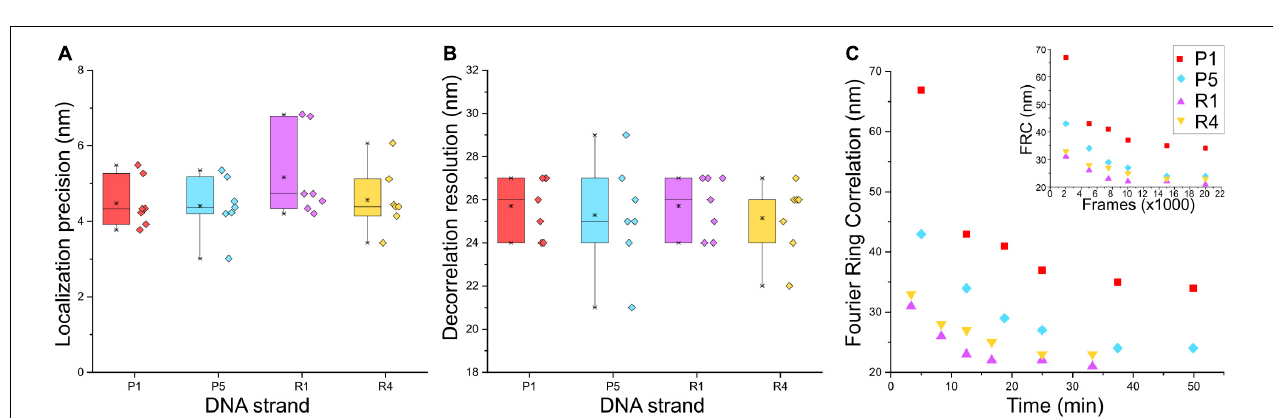
FIGURE 2 | (a) A four-target overlay DNA-PAINT image of MNTB tissue with two calyx synapses and corresponding postsynaptic principal cell (stippled lines), capillaries (dotted lines), and a graphical representation of the calyx of Held (inset). (i–vii) Magnification of regions within the primary image (a) showing different protein morphologies and organization of tubulin, mitochondria, MAP2, and VGLUT1 within the MNTB. Scale bar 5 µ m (a) and 0.5 µ m (i–vii) .